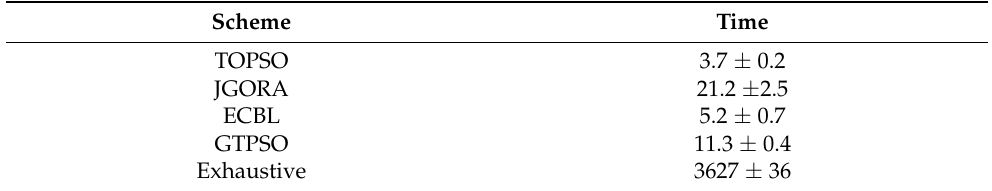
Table 2. Runtime of schemes